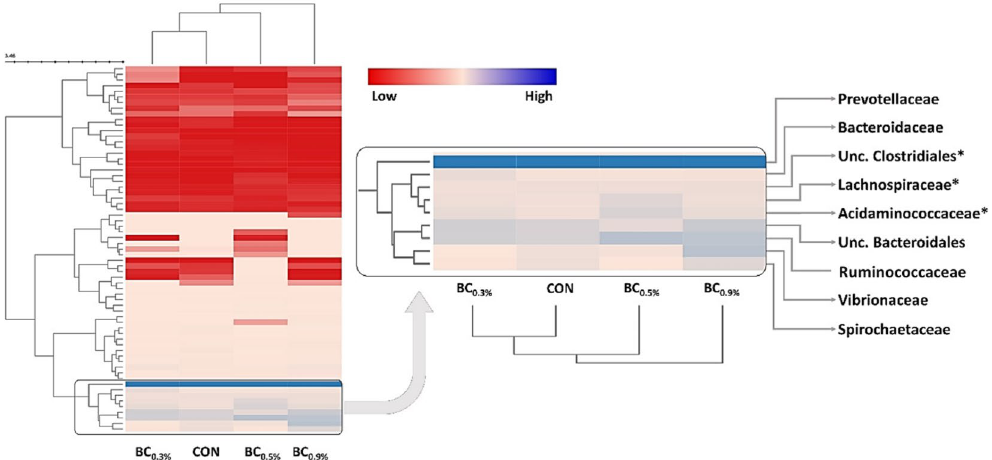
Figure 4. Heatmap presentation of relative abundance of representative families of observed OTUs. Treatments (columns) and families (rows) are clustered using Bray–Curtis dissimilarity test and Ward linkage. Normalized relative abundance are plotted from low (red), mid (peach), and high (blue). Heatmap clustering was generated in MetaCOMET 24 utilizing the InCHlib application 28 . CON (no buffer added); BC 0.3% (0.3% buffer); BC 0.5% (0.5% buffer); BC 0.9% (0.9% buffer); asterisk (*): represents significant differences ( P <